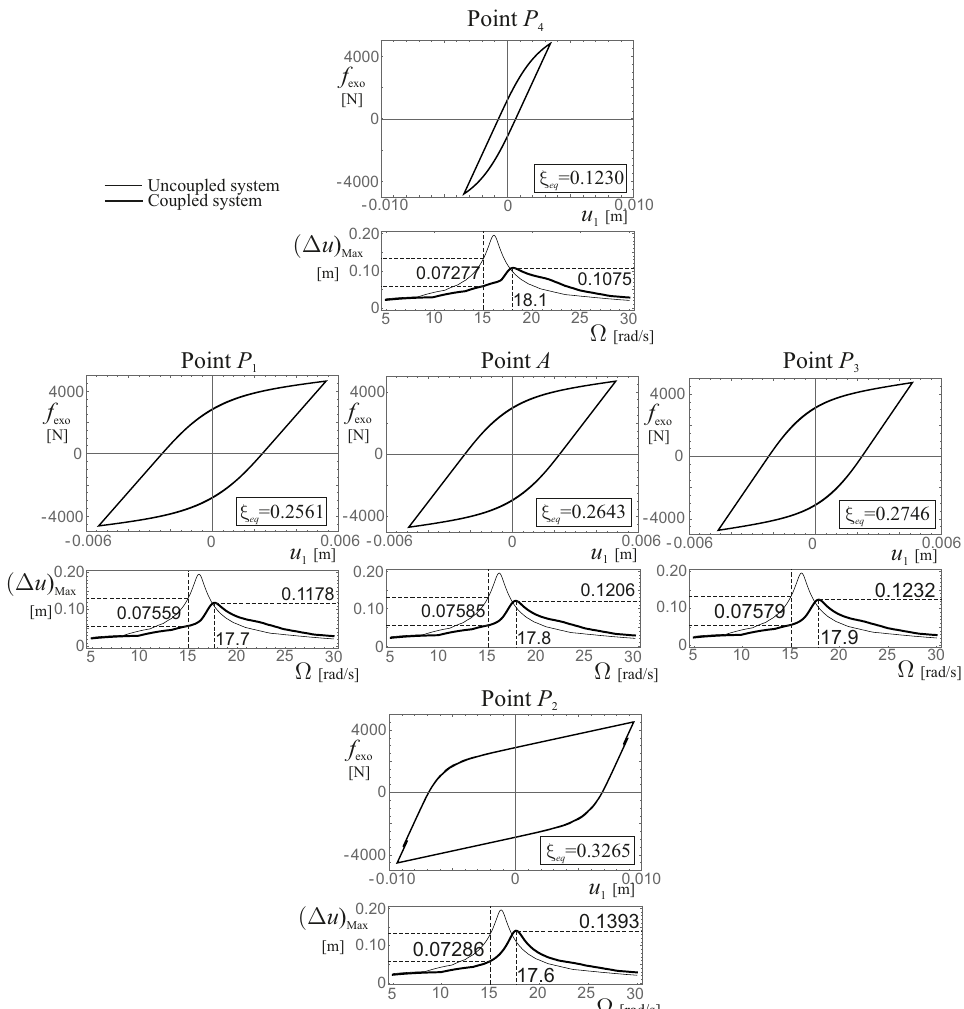
Figure 5. Stationary hysteretic cycles and frequency-amplitude curves of the drift (points labelled in Figure 3b, ψ = 0.1, γ = 0.1, A s = 0.7 g m/s 2